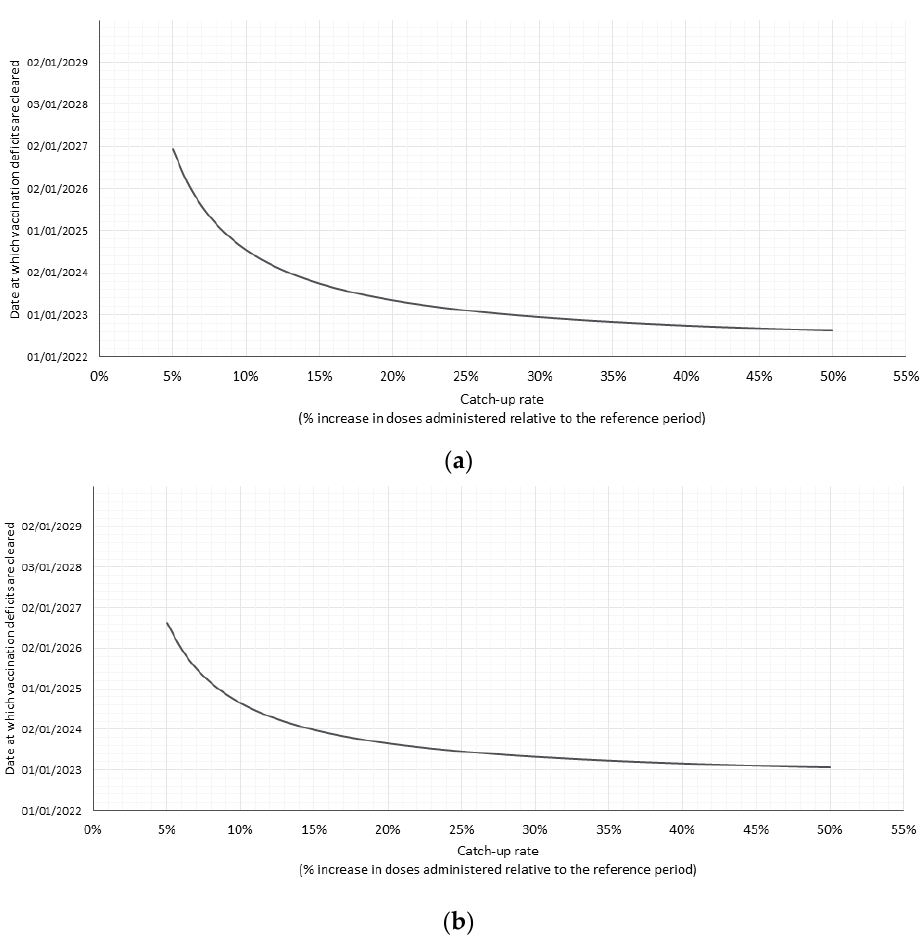
Figure 3. Date at which cumulative missed HPV doses reaches zero according to catch ‐ up rate in ( a ) Switzerland and ( b )